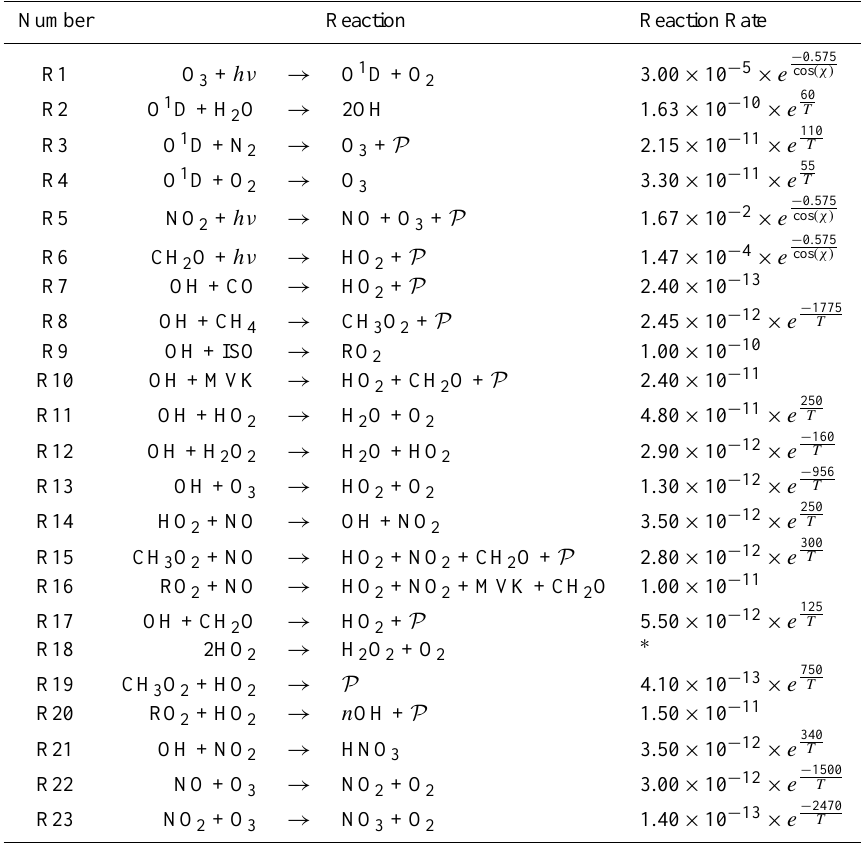
Table 1. Chemical reaction scheme used in the reduced scheme with T the absolute temperature in Kelvin and χ the solar zenith angle. First- order reaction rates are in s − 1 , second-order reaction rates in cm 3 molecule − 1 s − 1 . In R19 n = 0 (no OH-recycling), P depicts a product which is not further evaluated in the chemical reaction scheme. ISO refers to isoprene, where all its oxidation products (MVK; methyl vinyl ketone and MACR; methacrolein) are lumped into a single species